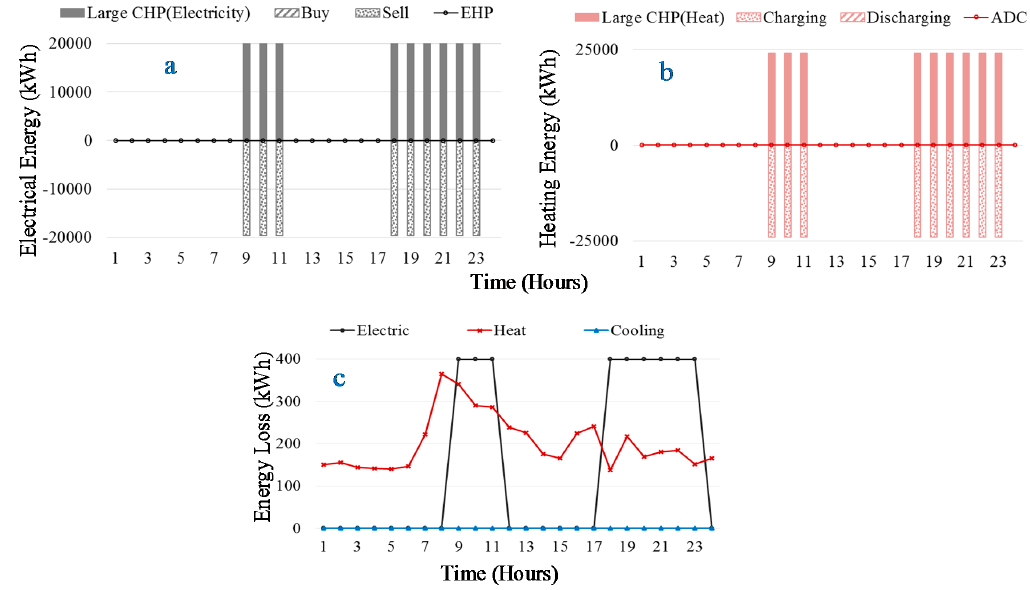
Figure 13. Energy balancing of EEN in winter season: ( a ) electrical energy; ( b ) heating energy; and ( c ) energy loss.